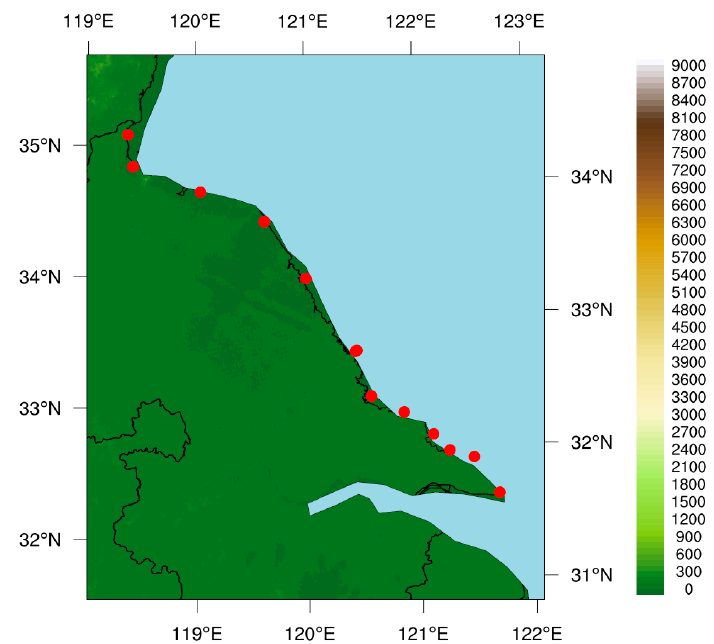
Figure 2. Domain 02 of the WRF model. There are 14 wind observation towers (red dots) distributed along the coastal area of Jiangsu province; each tower records 10 m above ground level (AGL), 30 m AGL, 50 m AGL, and 70 m AGL wind observations.